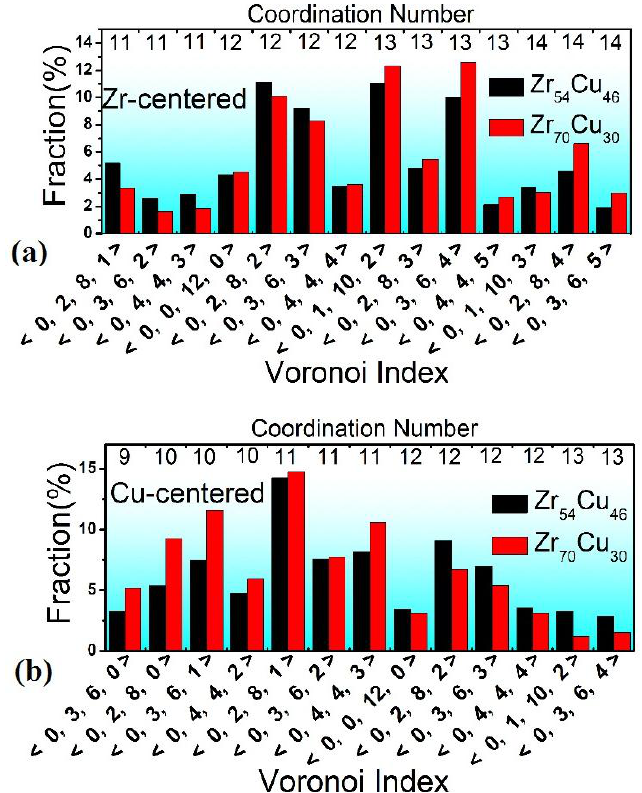
Figure 5. Distribution of the major Voronoi clusters, including: ( a ) Zr-centered VCs and ( b ) Cu-centered VCs. Only those whose fractions are larger than 1.5% are selected. The CN value denotes the number of shell atoms of the corresponding VC, i.e. , the CN around the center